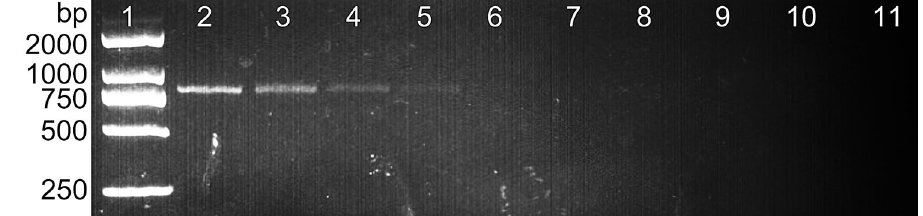
Figure 4. The sensitivity of the SCAR markers (L57F/L57R) with different amounts of DNA template in a 25 µl PCR mixture. Lane 1: DL500 DNA ladder, Lane 2: 50 ng/µl, Lane 3: 25 ng/µl, Lane 4: 10 ng/µl, Lane 5: 5 ng/µl, Lane 6: 1 ng/µl, Lane 7: 100 pg/µl, Lane 8: 10 pg/µl, Lane 9: 1 pg/µl, lane 10: 0.1 pg/µl, and lane 11: ddH 2